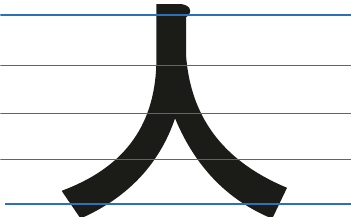
Figure 3: Horizontal stroke density feature extraction.